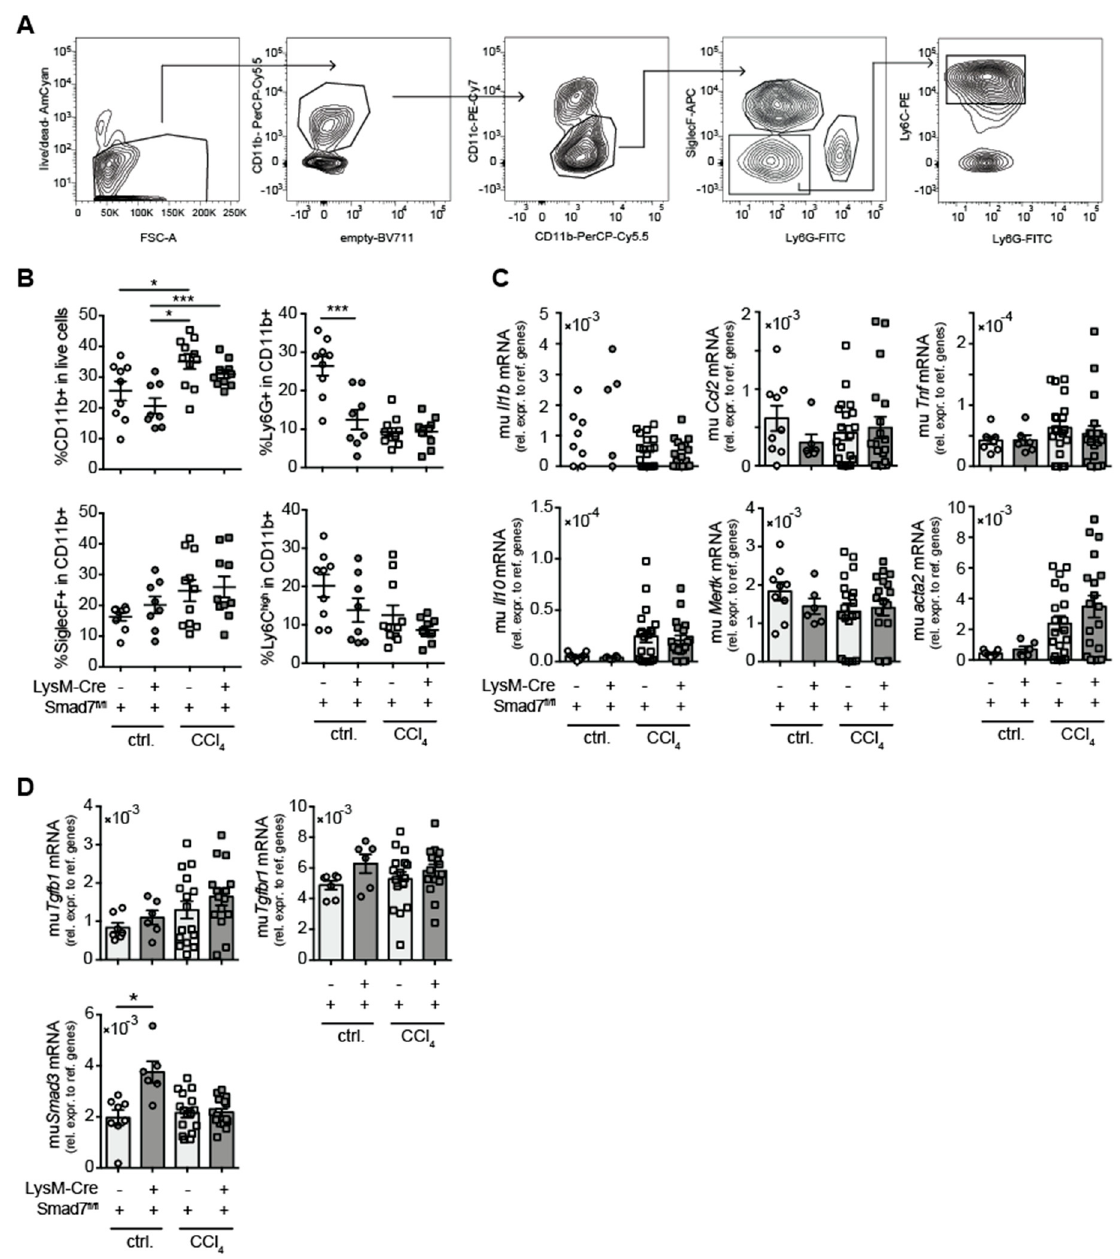
Figure 2. Myeloid deletion of Smad7 changed neither hepatic myeloid-cell infiltration nor hepatic expression of (anti-) inflammatory and fibrosis markers after chronic CCl 4 application. LysM-Cre pos Smad7 ∆ / ∆ and Smad7 fl/fl littermates were injected intraperitoneally with CCl 4 in corn oil or corn oil alone (ctrl.) twice a week for 6 wks. Mice were sacrificed 24 h